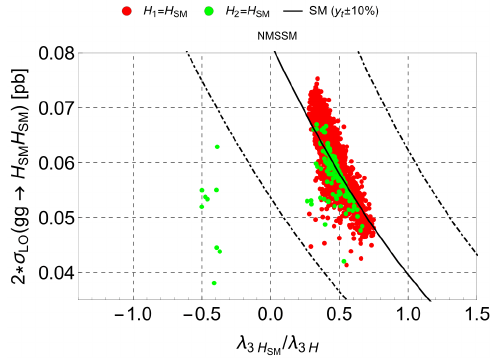
Figure 18 . Same as figure 17 but for the